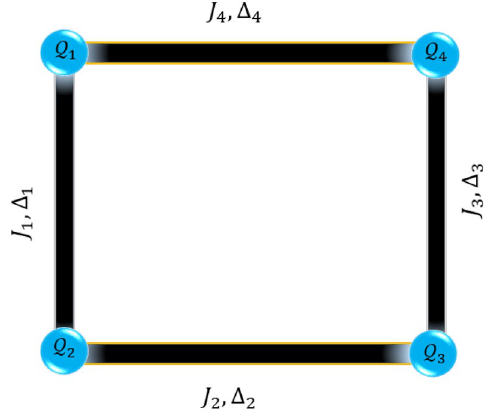
Figure 1. Schematic structure of a four-qubit ( Q 1 , Q 2 , Q 3 , and Q 4 ) square complex on the Heisenberg XXZ model with the corresponding exchange anisotropy and spin